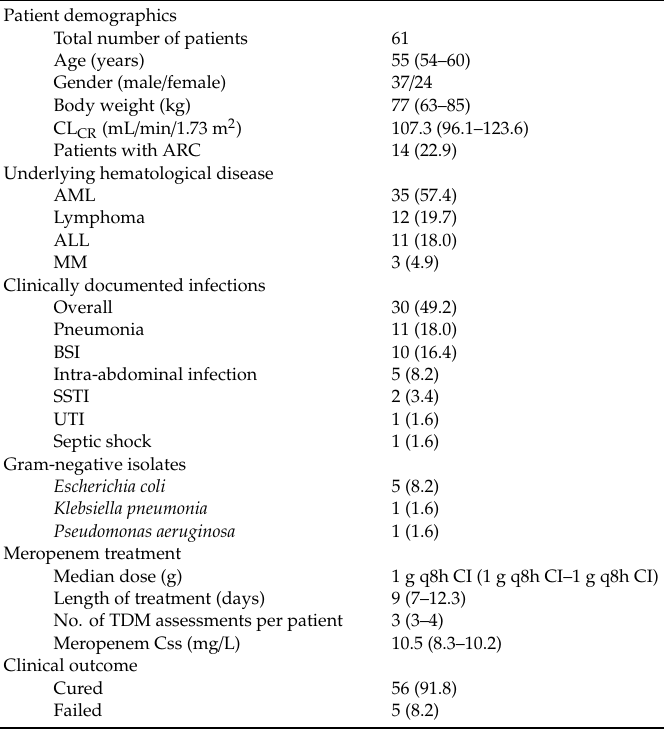
Table 1. Patient